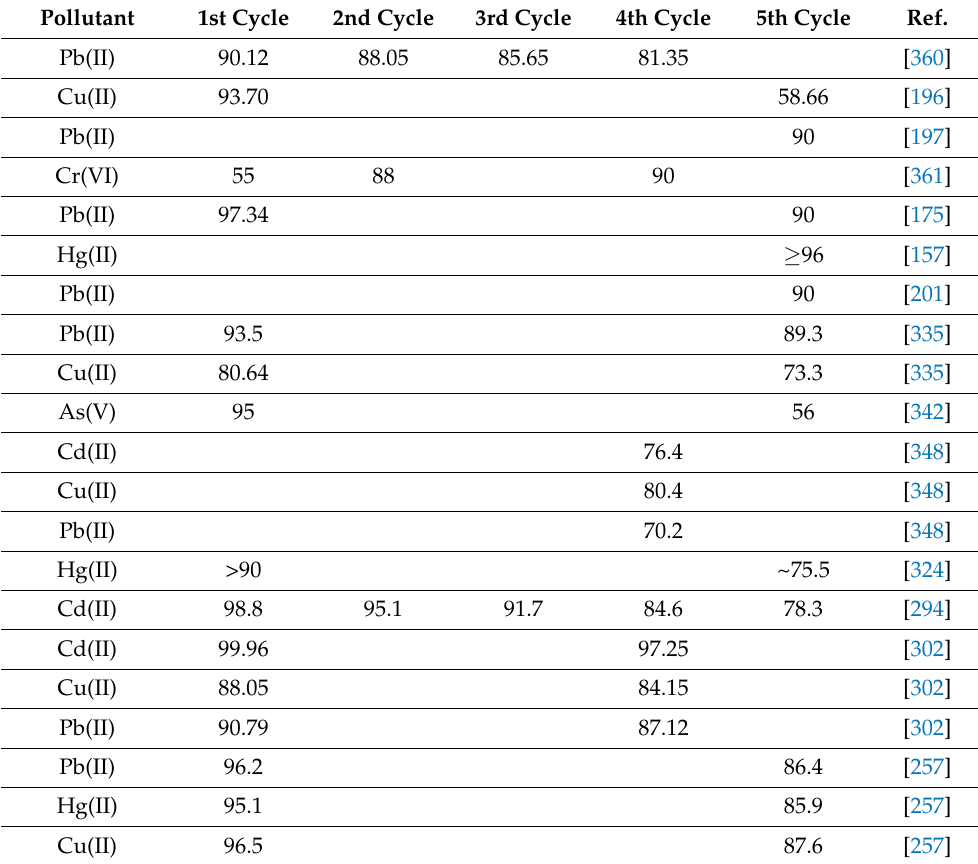
Table 6. Recycling efficiency